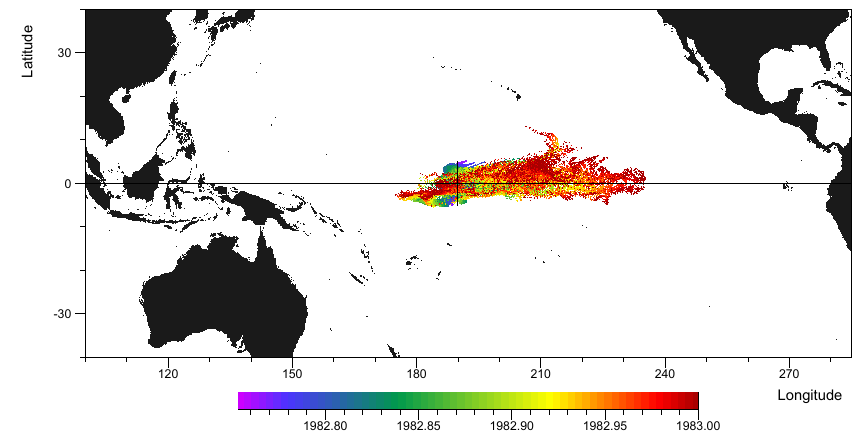
Figure 27. Water particle positions plotted every 5 days between 2 October 1982 and the end of the year, the date being denoted by the colour of each dot. For the initial state, one particle was placed at the centre of each model grid cell, lying along the black line, having a water temperature of greater than 29 ◦